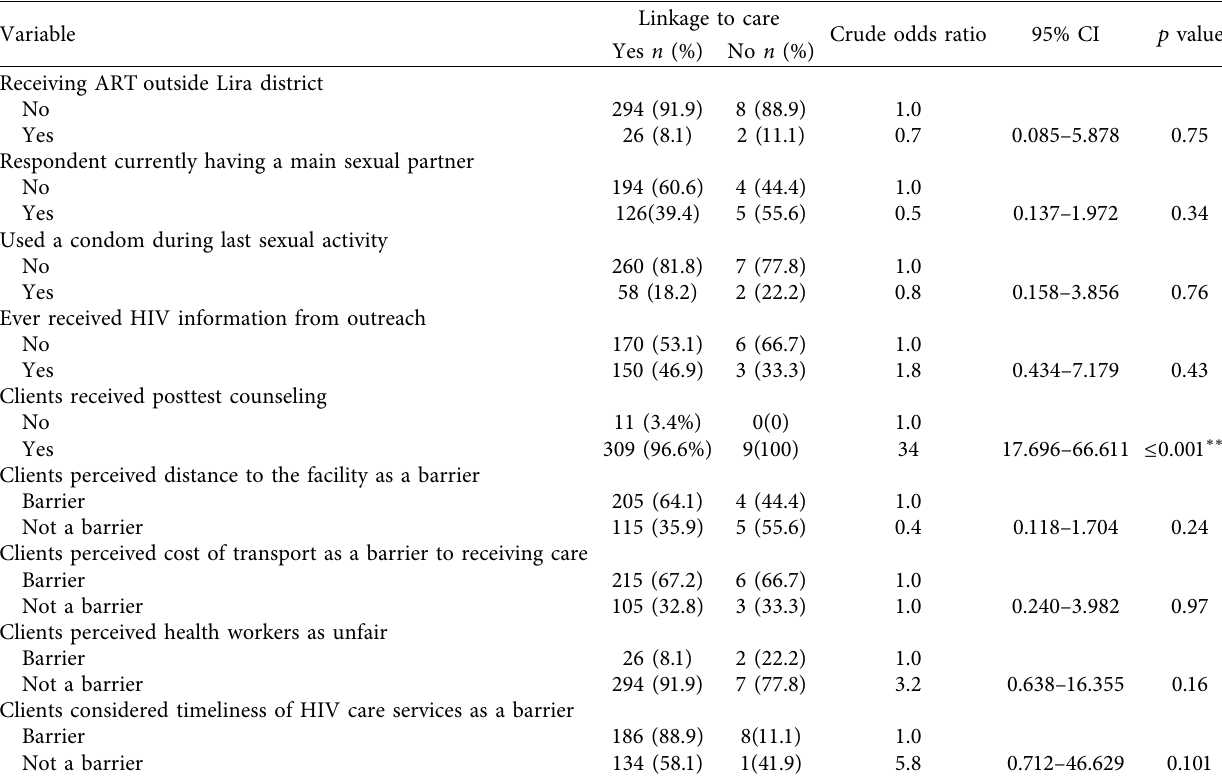
Table 3: Personal factors associated with linkage to care following community-level identification.